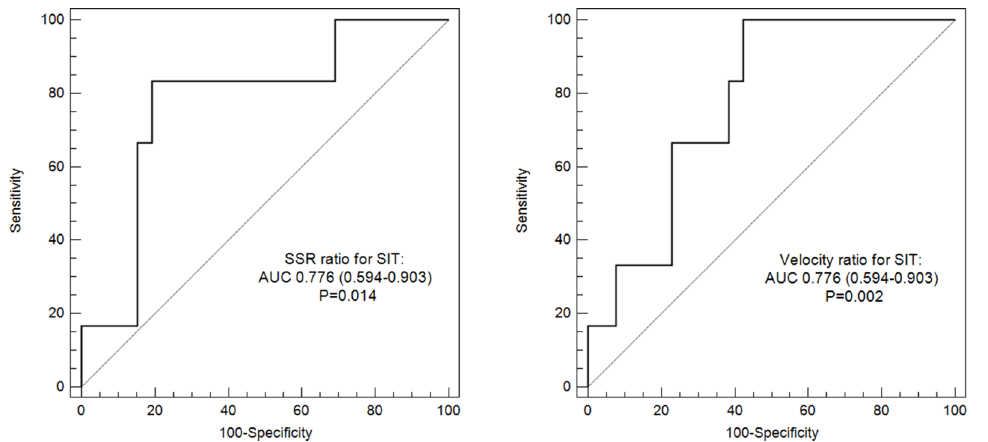
Figure 4. Receiver operating characteristic curves for shear strain rate ratio (left) and velocity ratio (right) to predict recurrent ischemic stroke in the territory of the qualifying artery. SIT indicates recurrent ischemic stroke in the territory of the qualifying artery; AUC, area under curve.